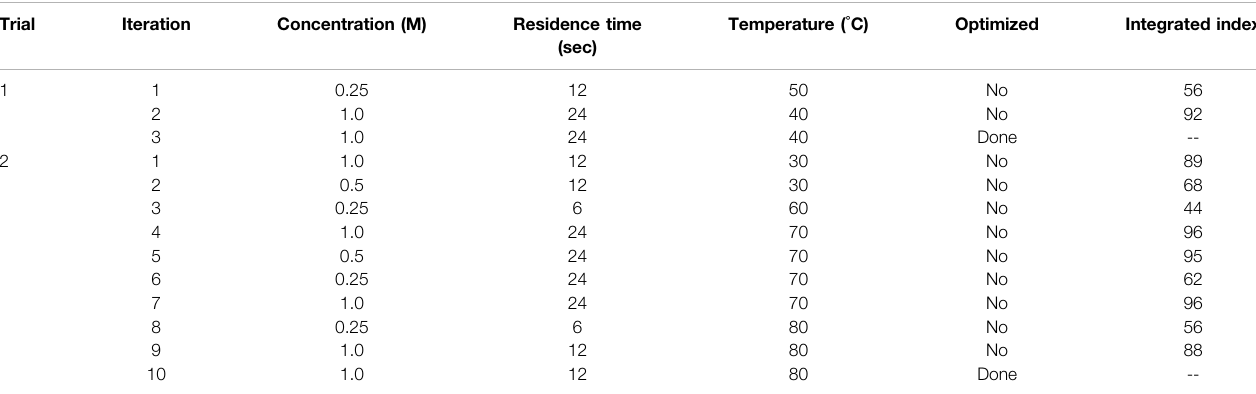
TABLE 2 | Results for Bayesian optimization process a . Trial